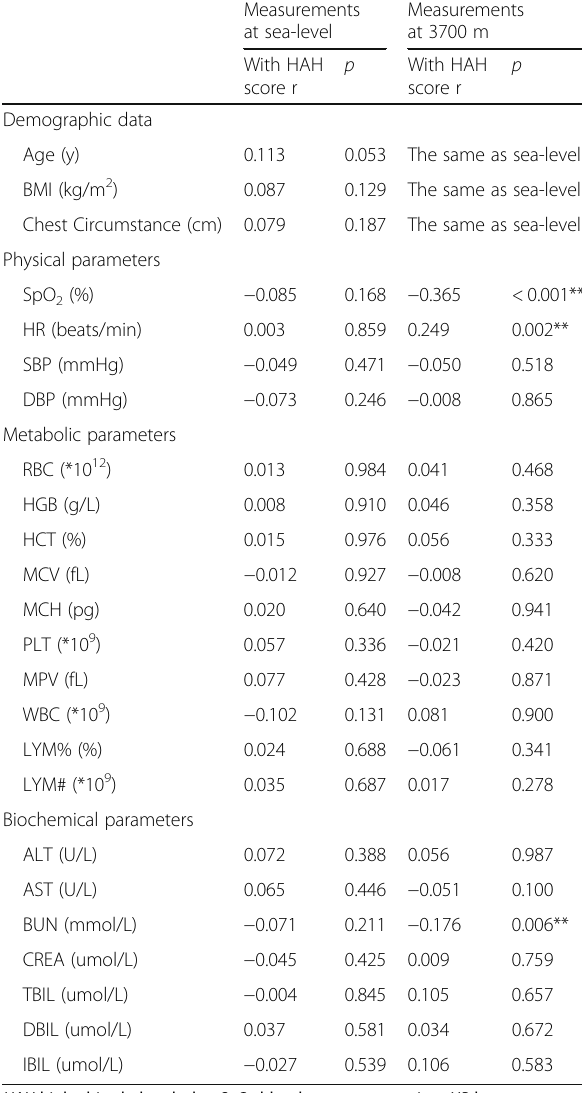
Table 3 Relationships between HAH score and all the parameters at both sea level and 3700 m ( N = 318) Measurements at